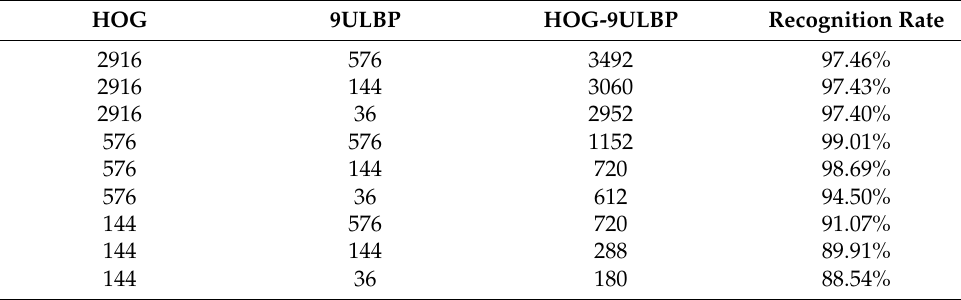
Table 3. Performance of HOG-9ULBP descriptors with different